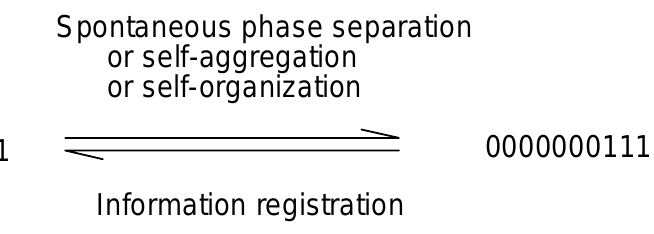
Figure 11. Informational registration as a binary string and the information loss due to a possible spontaneous